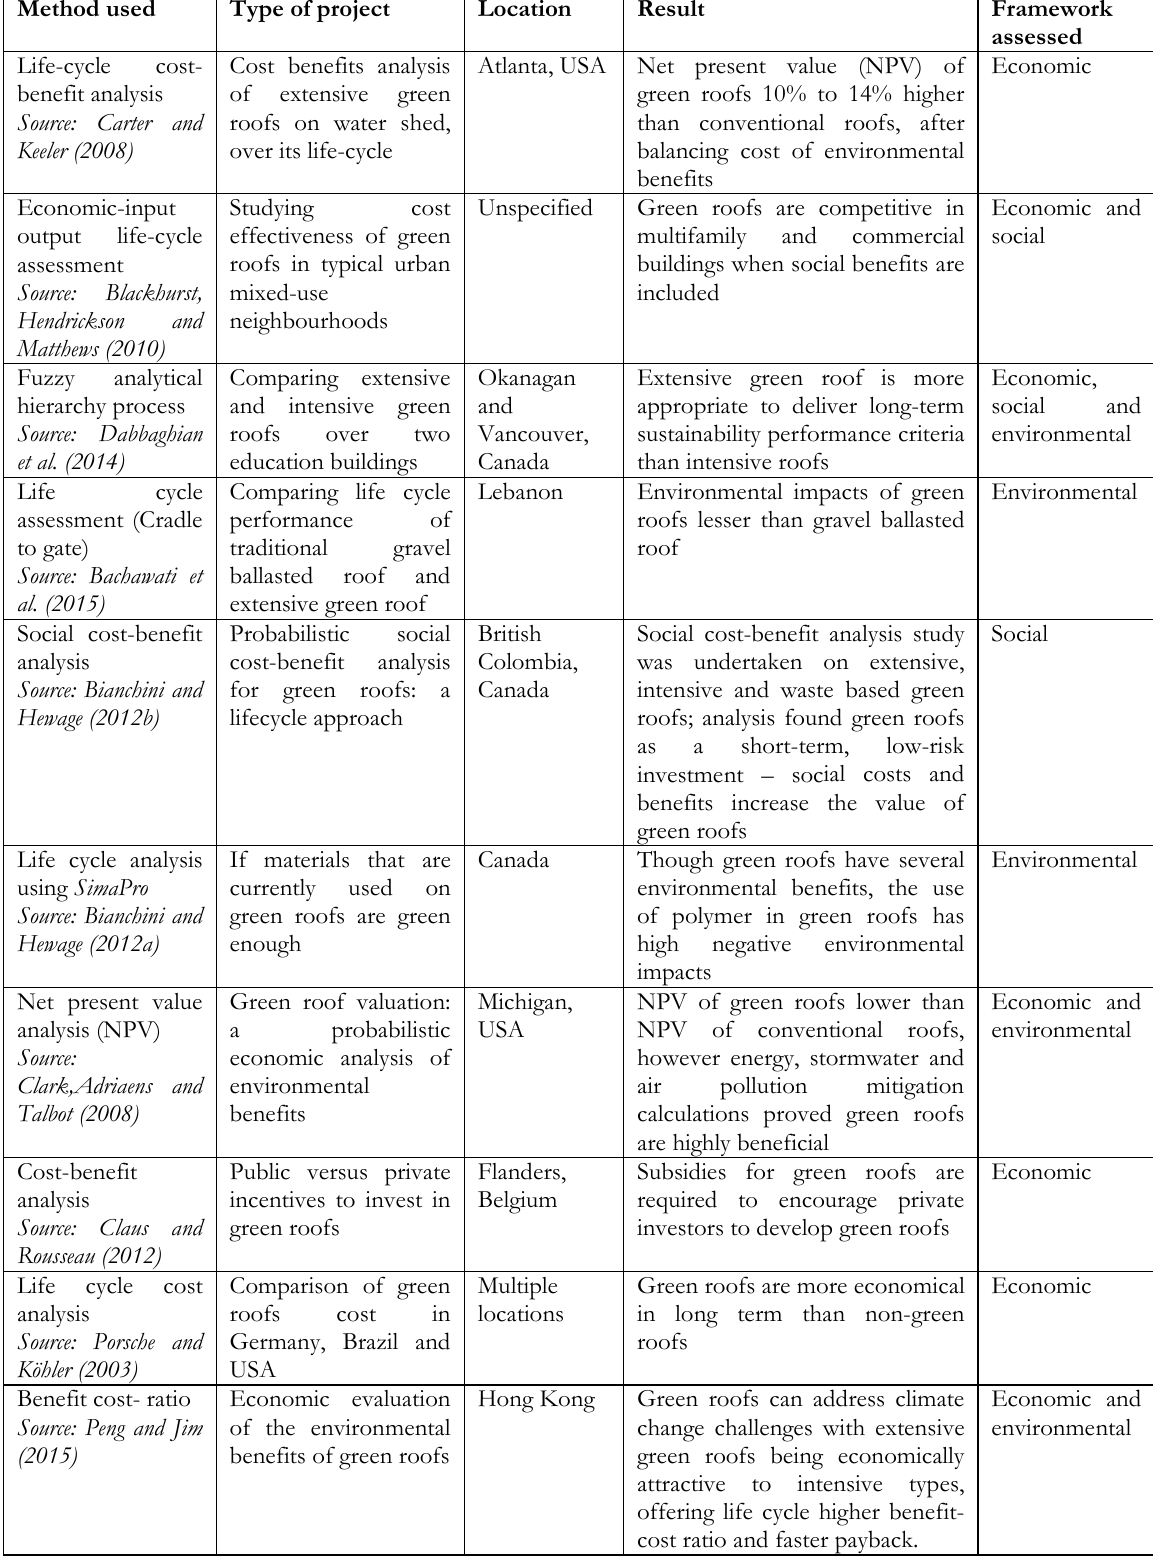
Table 1: Summary of previous green roof evaluation research Method